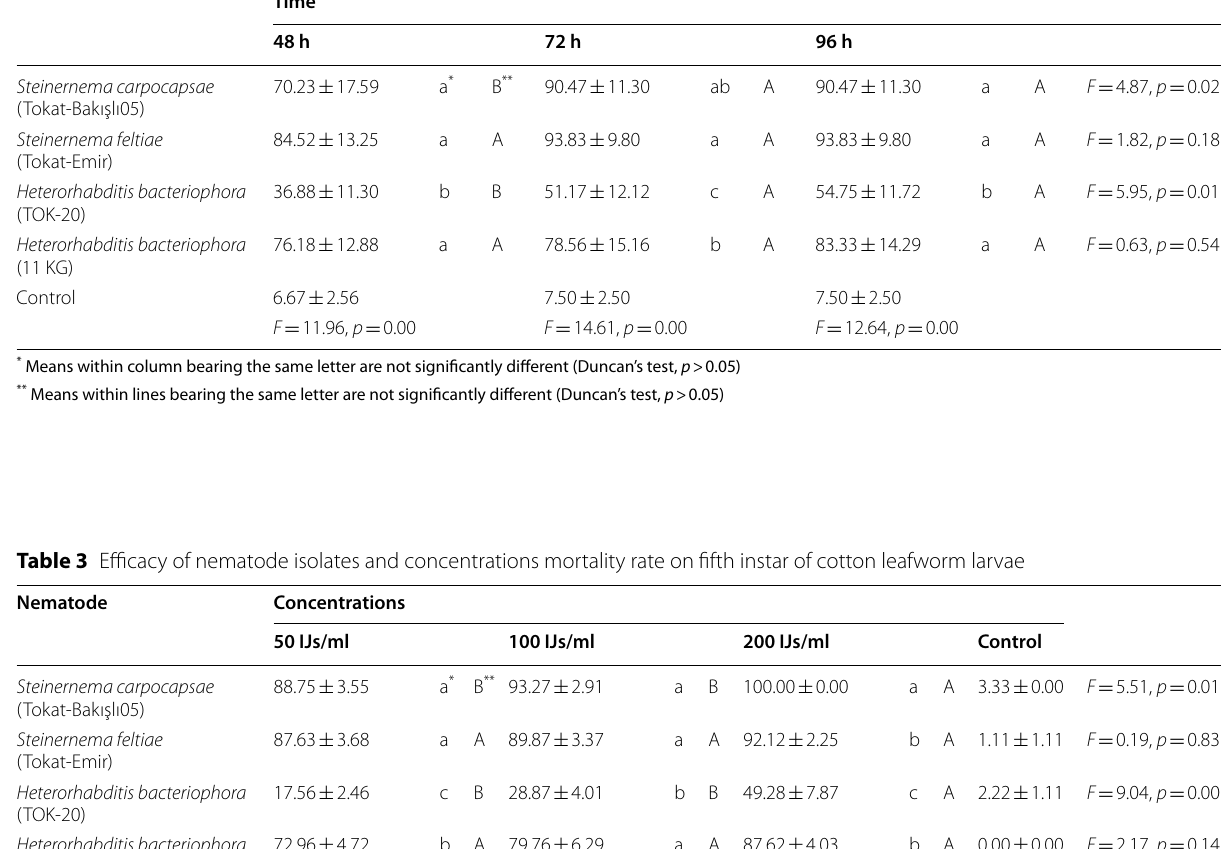
Table 2 Mortality rates of cotton leafworm larvae at different exposure times